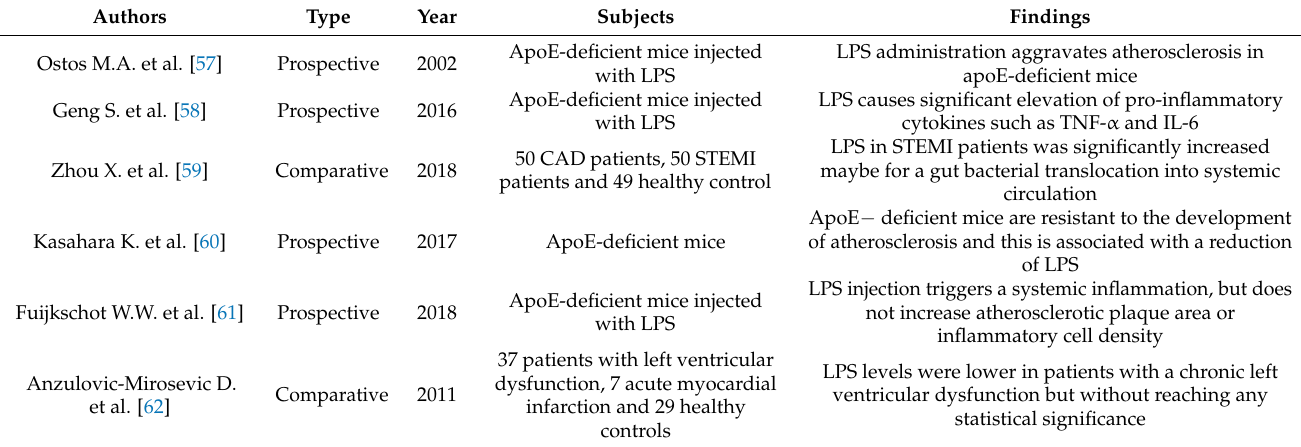
Table 4. Studies on the association between LPS and cardiovascular